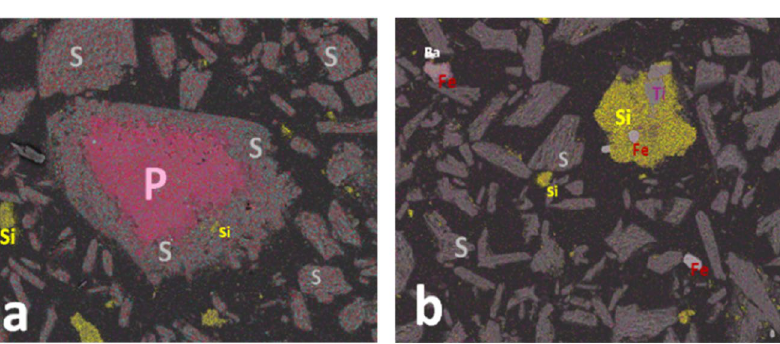
Figure 4. The distribution of the impurities P and Si wrapped in PG ( a ) and the impurities Fe and Ti wrapped in quartz phase ( b ), as determined by